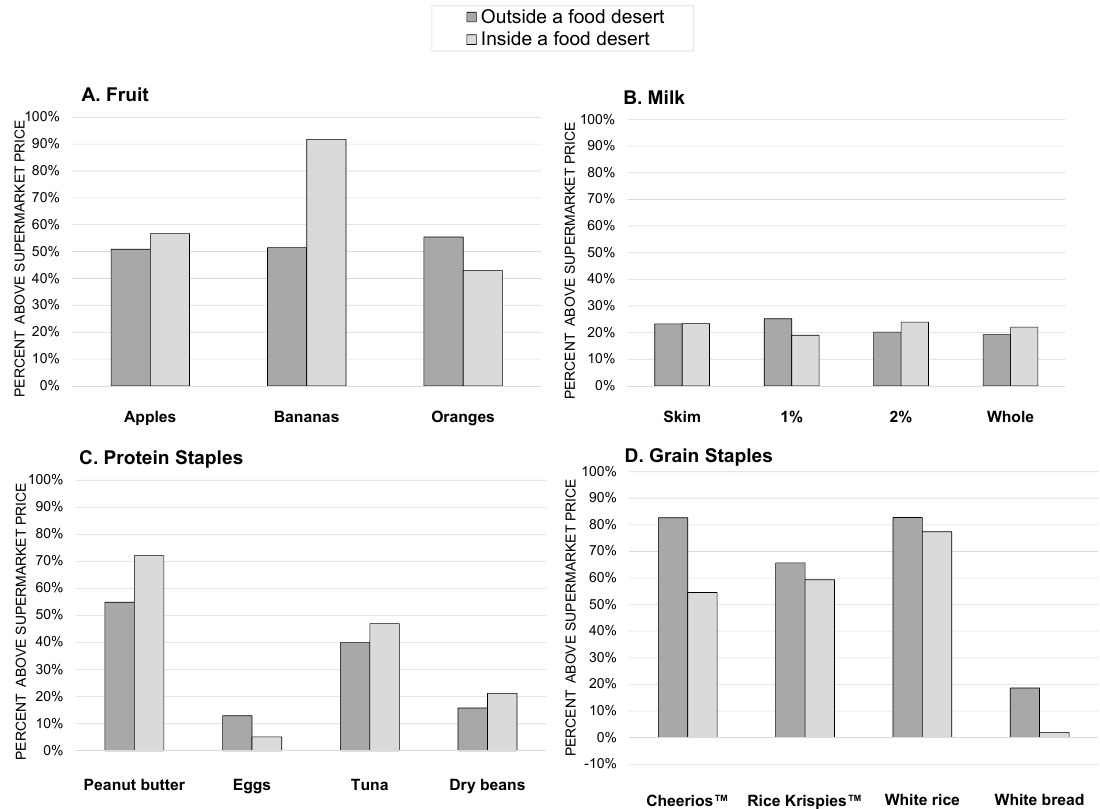
Figure 2. Price Differentials at Isolated Small Food Stores by Food Desert Status, Minneapolis and St. Paul, MN, 2014.